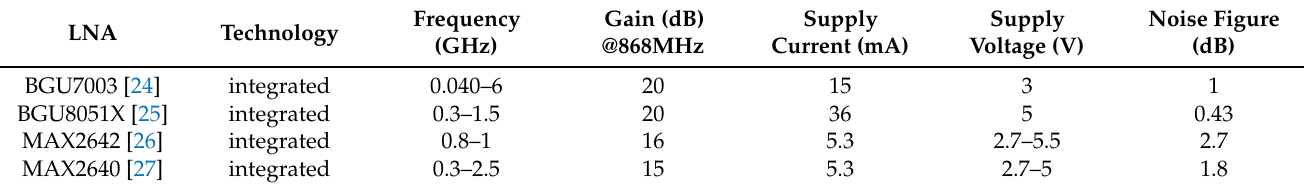
Table 2. Comparative study of commercialized off-the-shelf